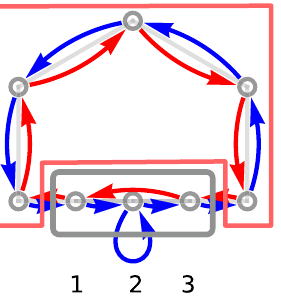
FIG. 10. An example of the h J s 31 i diagram (red) and the h J s 12 i diagram (blue). Passive particles are boxed in gray, and the active ones are boxed in